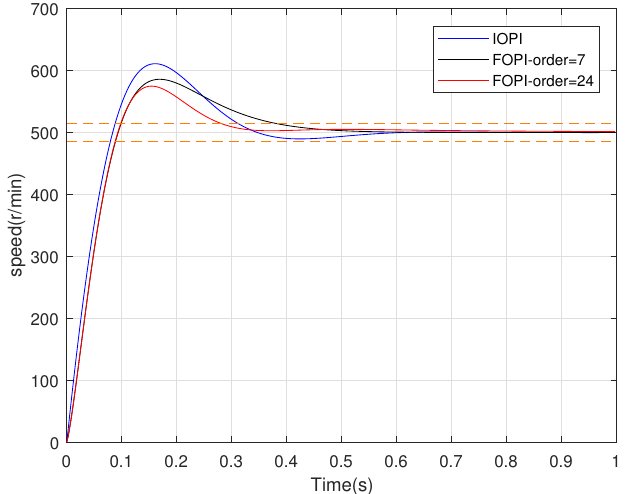
Figure 11. Speed response comparison with different